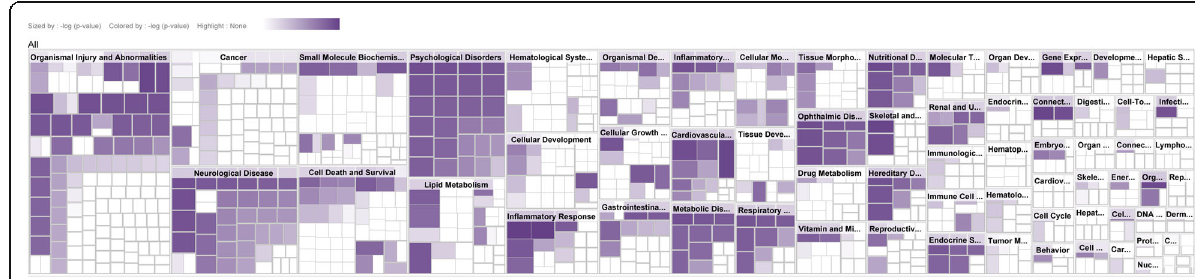
Fig. 4 The heat map of diseases and toxic functions related to target proteins of VOAAF